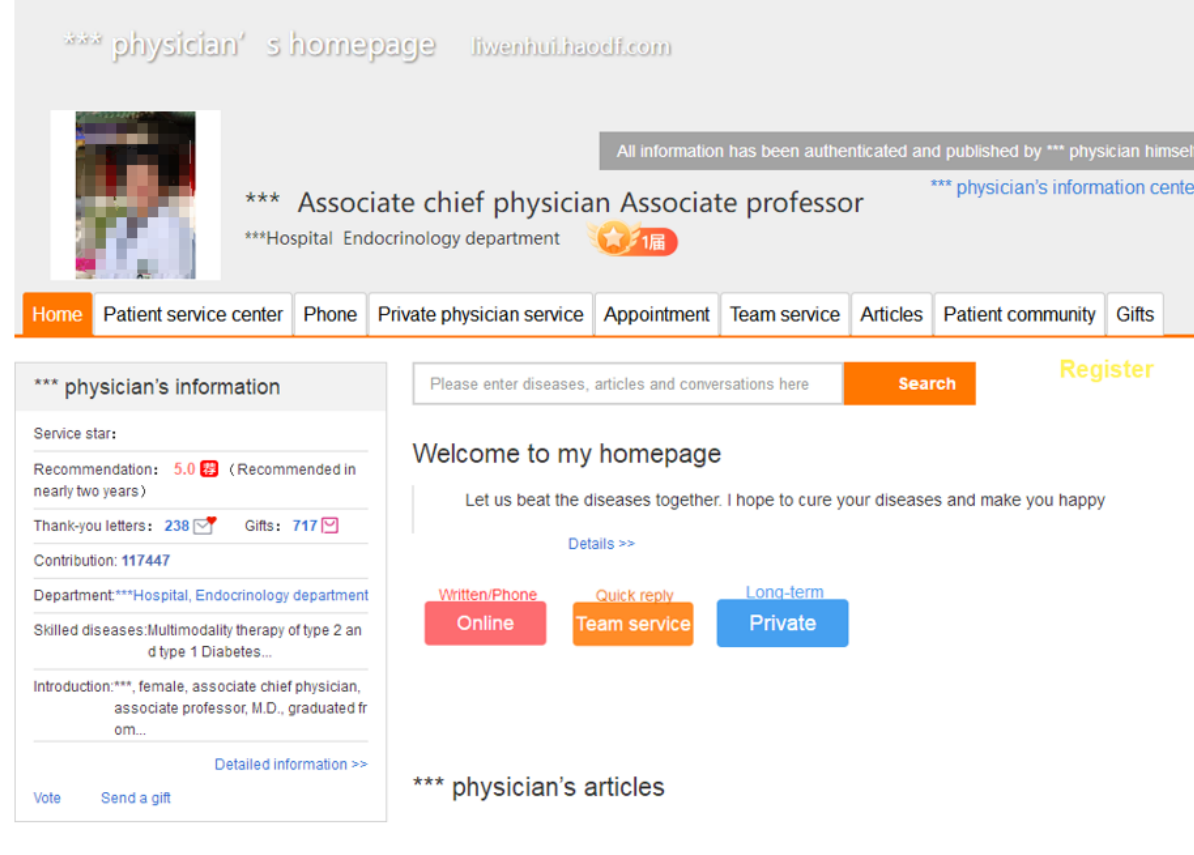
Figure 2. Physician’s